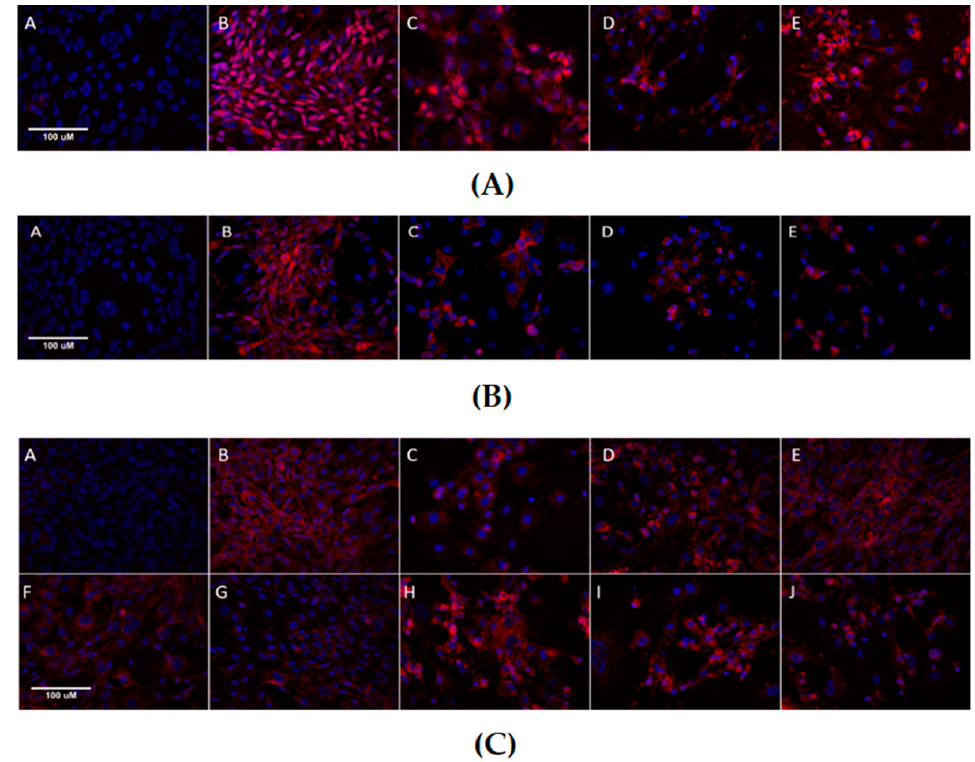
Figure 6. Representative microscopic images presenting immunofluorescence of adipogenic proteins in 3T3-L1 cells upon treatment with metformin and simvastatin, captured on the Axioskop 2 MOT microscope, 400×, scale 100 µM. ( A ) Immunofluorescence of peroxisome proliferator-activated receptor γ (PPAR γ ) in 3T3-L1 cells upon treatment with metformin and simvastatin. Blue = DAPI, cell nuclei; red = Cy5-PE, PPAR γ . A = negative control, B = differentiated cells, C = cells treated with the combination of metformin 200 µM and simvastatin 100 nM, D = cells treated with the combination of metformin 2 mM and simvastatin 1 µM, E = cells treated with the combination of metformin 4 mM and simvastatin 2 µM; ( B ) Immunofluorescence of CCAAT/enhancer binding protein α (C/EBP α ) in 3T3-L1 cells upon treatment with metformin and simvastatin. Blue = DAPI, cell nuclei; red = Cy5-PE, C/EBP α . A = negative control, B = differentiated cells, C = cells treated with the combination of metformin 200 µM and simvastatin 100 nM, D = cells treated with the combination of metformin 2 mM and simvastatin 1 µM, E = cells treated with the combination of metformin 4 mM and simvastatin 2 µM; ( C ) Immunofluorescence of SREBP-1C in 3T3-L1 cells upon treatment with metformin and simvastatin. Blue = DAPI, cell nuclei; red = Cy5-PE, SREBP-1C. A = negative control, B = differentiated cells, C = cells treated with metformin 200 µM, D = cells treated with metformin 4 mM, E = cells treated with simvastatin 100 nM, F = cells treated with simvastatin 1 µM, G = cells treated with simvastatin 2 µM, H = cells treated with the combination of metformin 200 µM and simvastatin 100 nM, I = cells treated with the combination of metformin 2 mM and simvastatin 1 µM, J = cells treated with the combination of metformin 4 mM and simvastatin 2 µM.